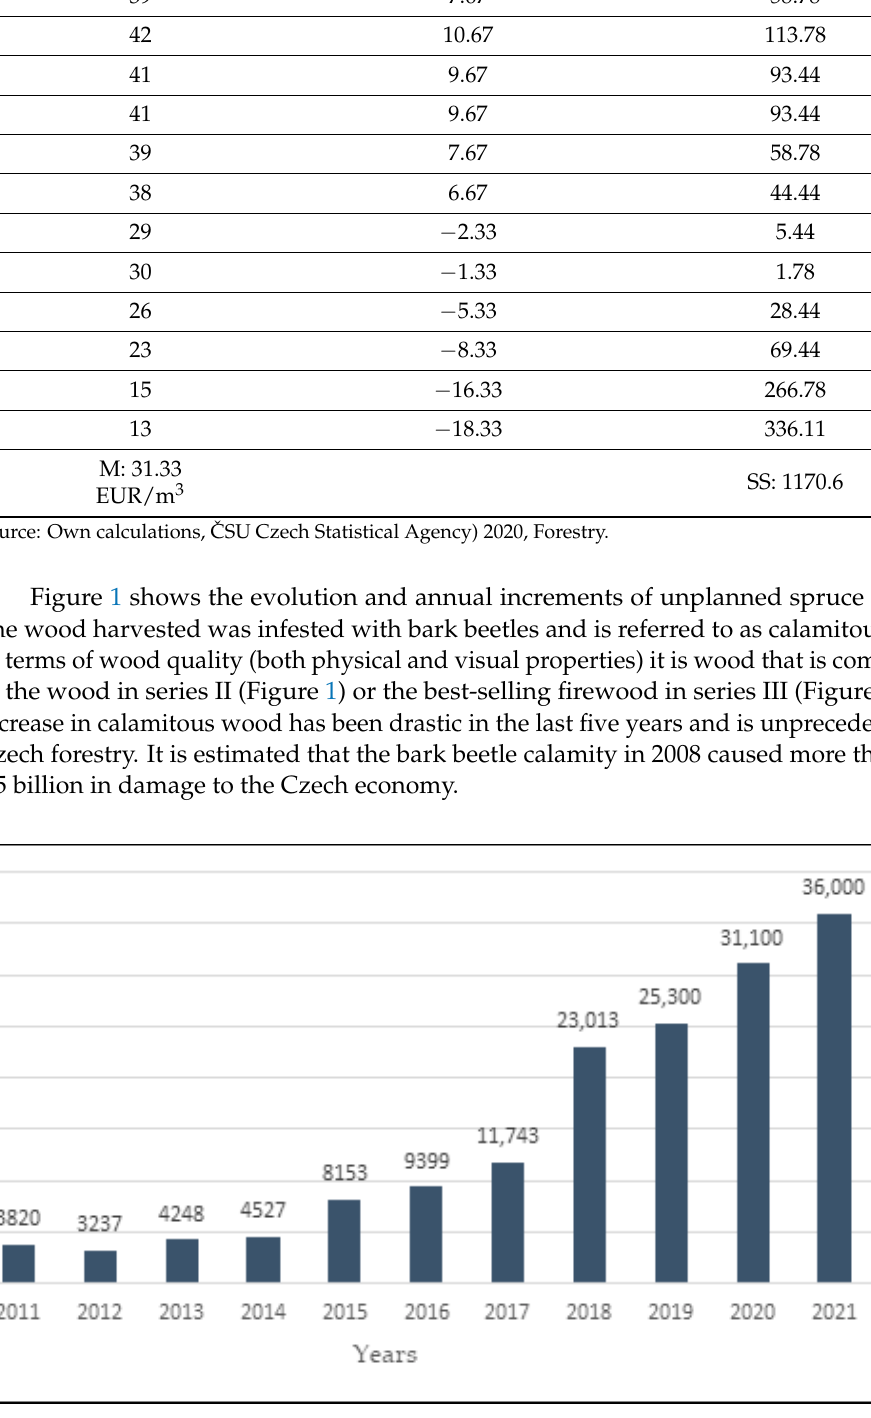
Table 4. Standard Deviation and Variance—The Price of spruce wood pulp for industrial use. EUR/m 3